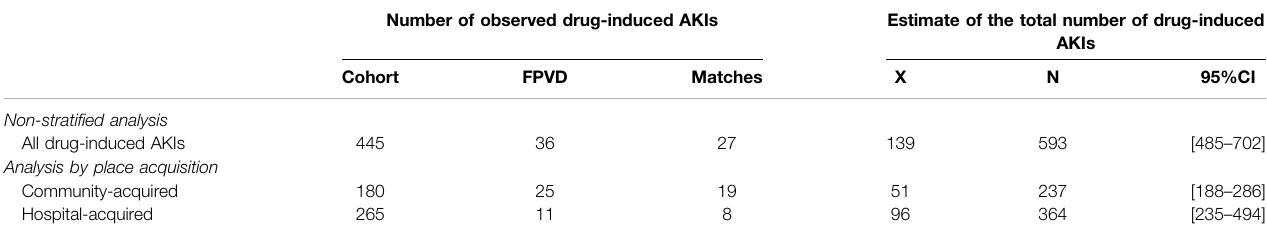
TABLE 5 | Estimation of the number of drug-induced AKIs using the capture-recapture method, as a function of the place of acquisition. Number of observed drug-induced